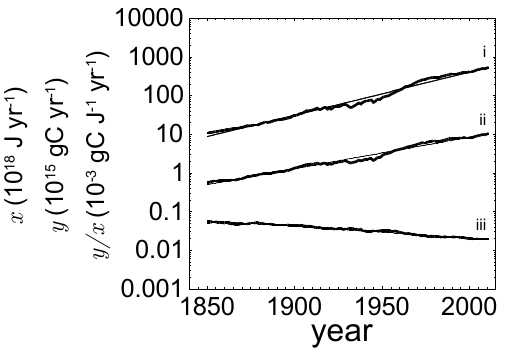
Figure 3. (i) Annual global primary energy use [11, 12, 13] with re- gression line given by ln x = a ( t − t 1 ); a = 0.0238 ± 0.0008yr − 1 ; t 1 = 1775 ± 3.5CE. (ii) Annual global anthropogenic CO 2 emis- sions [15, 16, 17] with regression line given by ln y = b ( t − t 1 ); b = 0.0179 ± 0.0006yr − 1 ; t 1 = AD1883 ± 1.7. (iii) Carbon inten- sity of global primary energy determined by the ratio y/x . See text for data sources and